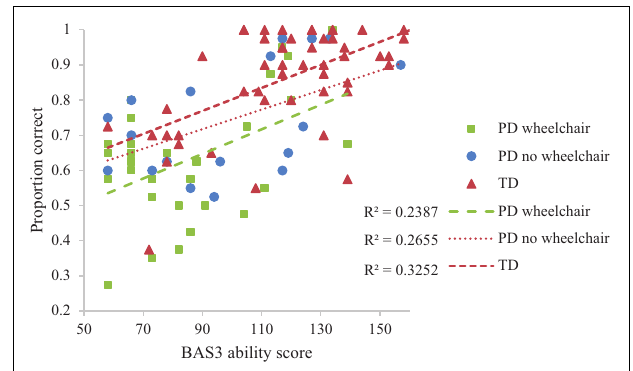
FIGURE 4 | Developmental trajectory of mental rotation